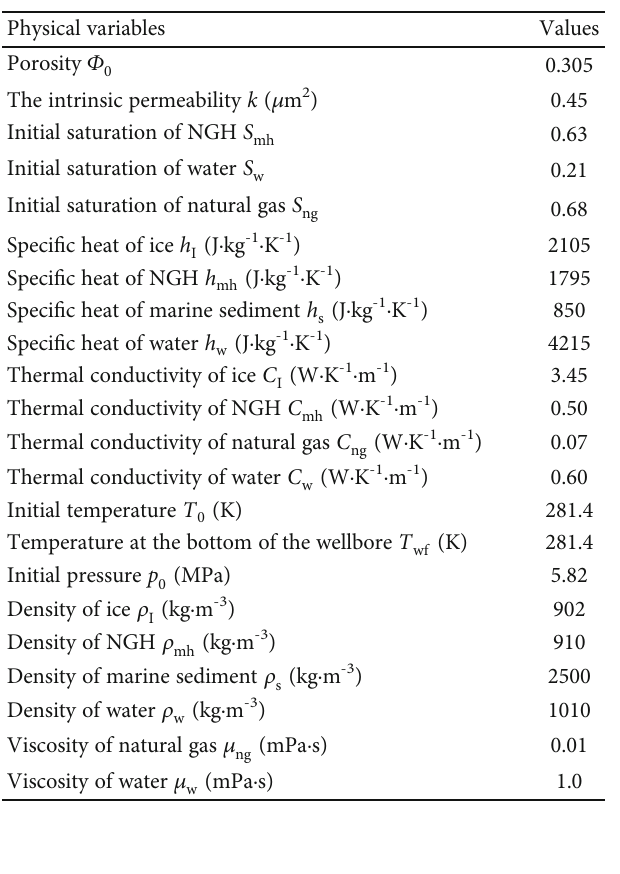
Table 1: The main experimental parameters and independent variables obtained for o ff shore NGH dissociation.